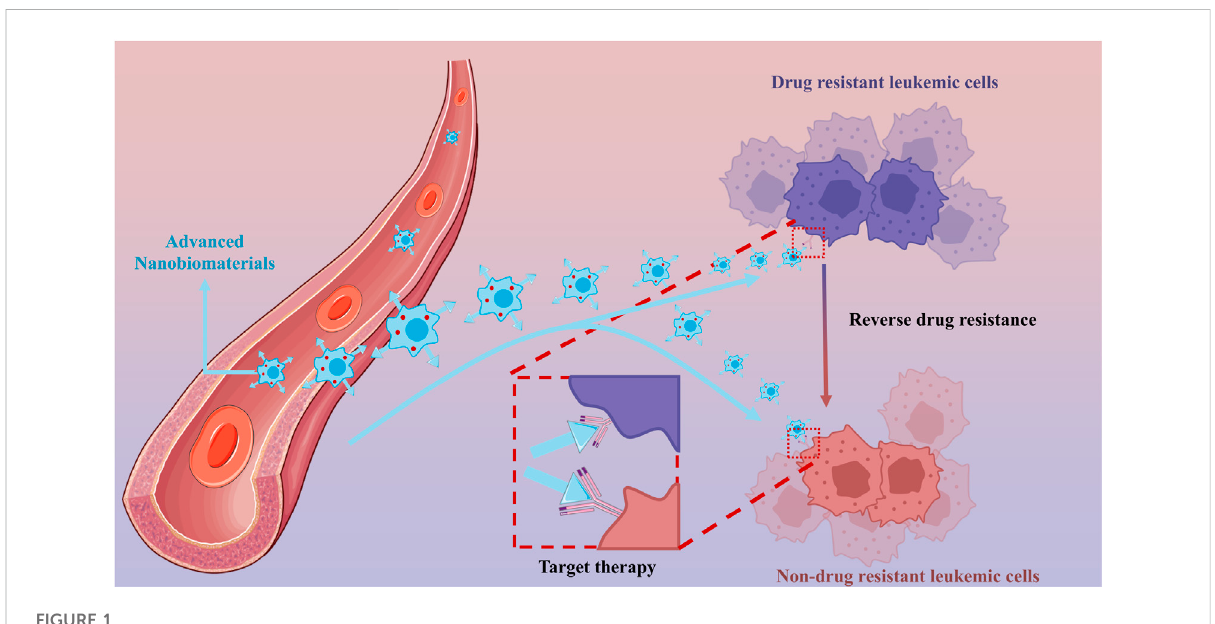
FIGURE 1 Advanced nanobiomaterials that can target therapy and reverse drug